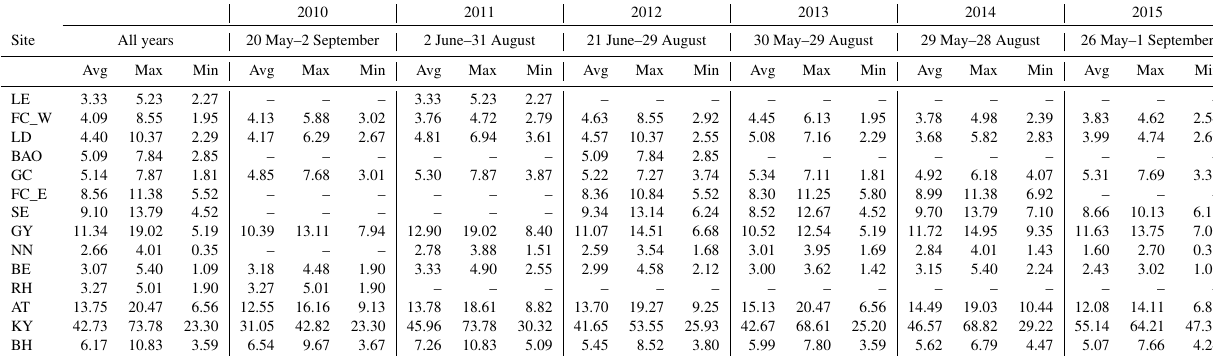
Table 2. Summary of summer NH 3 concentrations (units: µgm − 3 ) measured from 2010 to